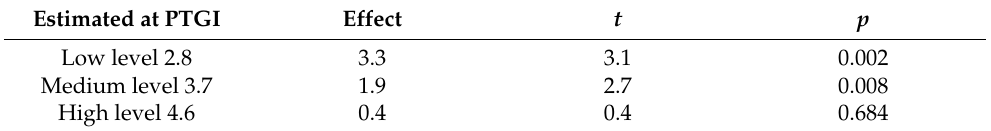
Table 3. Simple slope analysis of the moderation effect of posttraumatic growth in the association between sexual orientation and postnatal depressive